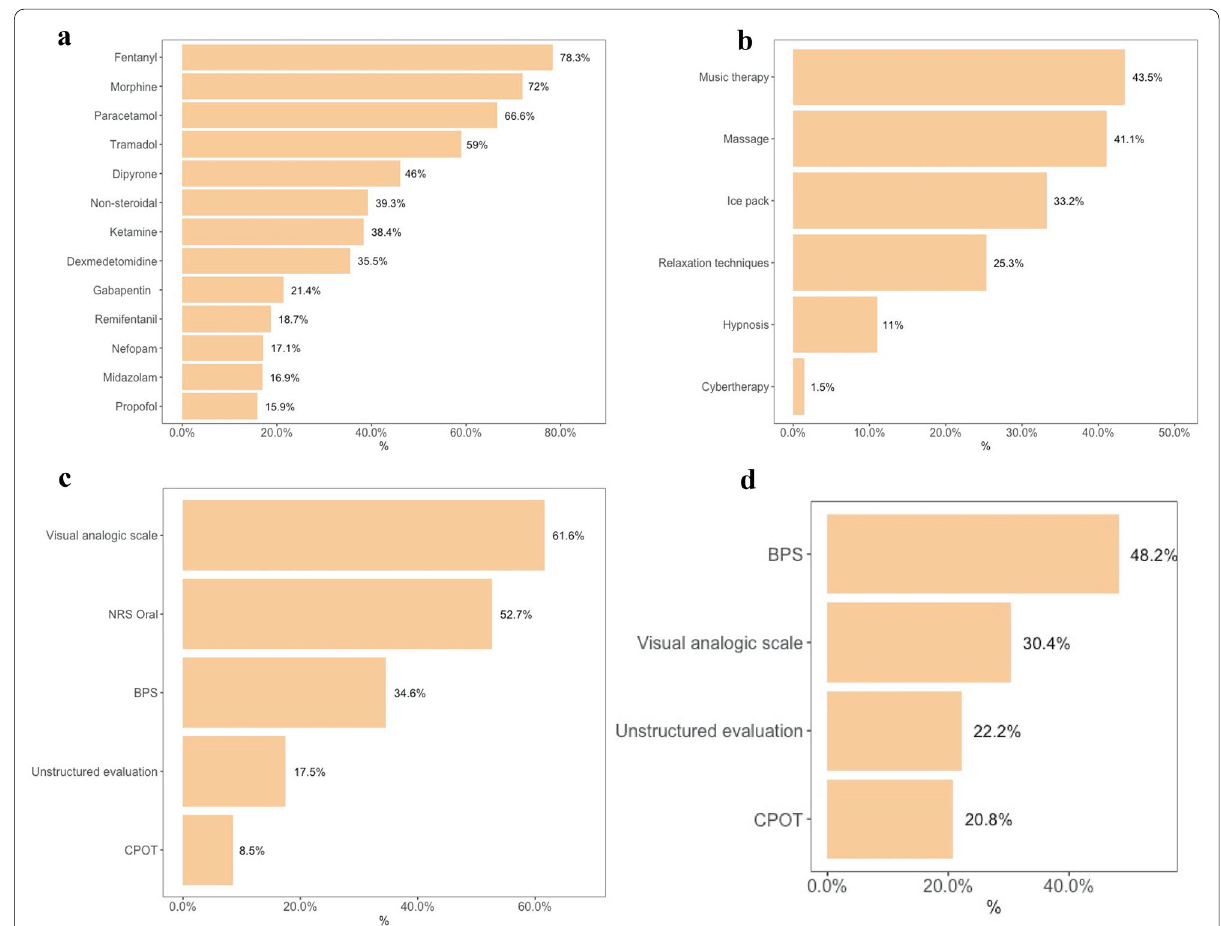
Fig. 1 Analgesia practices before the COVID‑19 pandemic. a Drugs for pain management; b nonpharmacologic strategies for pain management; c tools for pain assessment in patients able to communicate; d tools for pain assessment in patients unable to